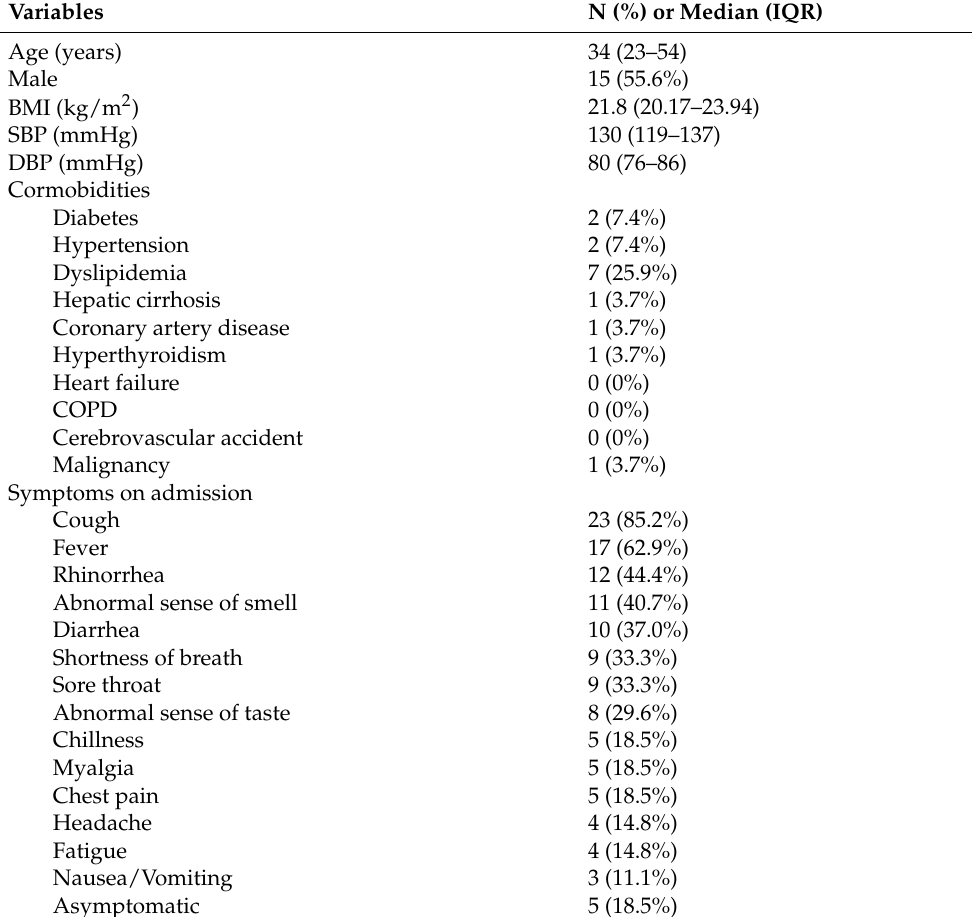
Table 1. Clinical characteristics ( n = 27).